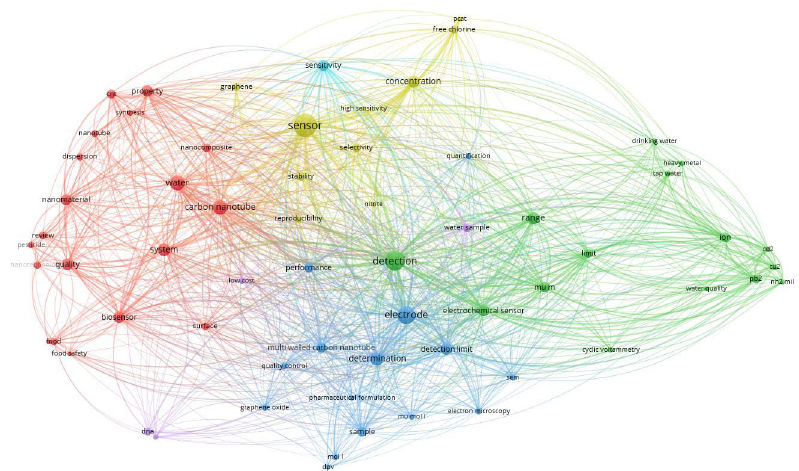
Figure 4. Network visualization using VOSviewer.